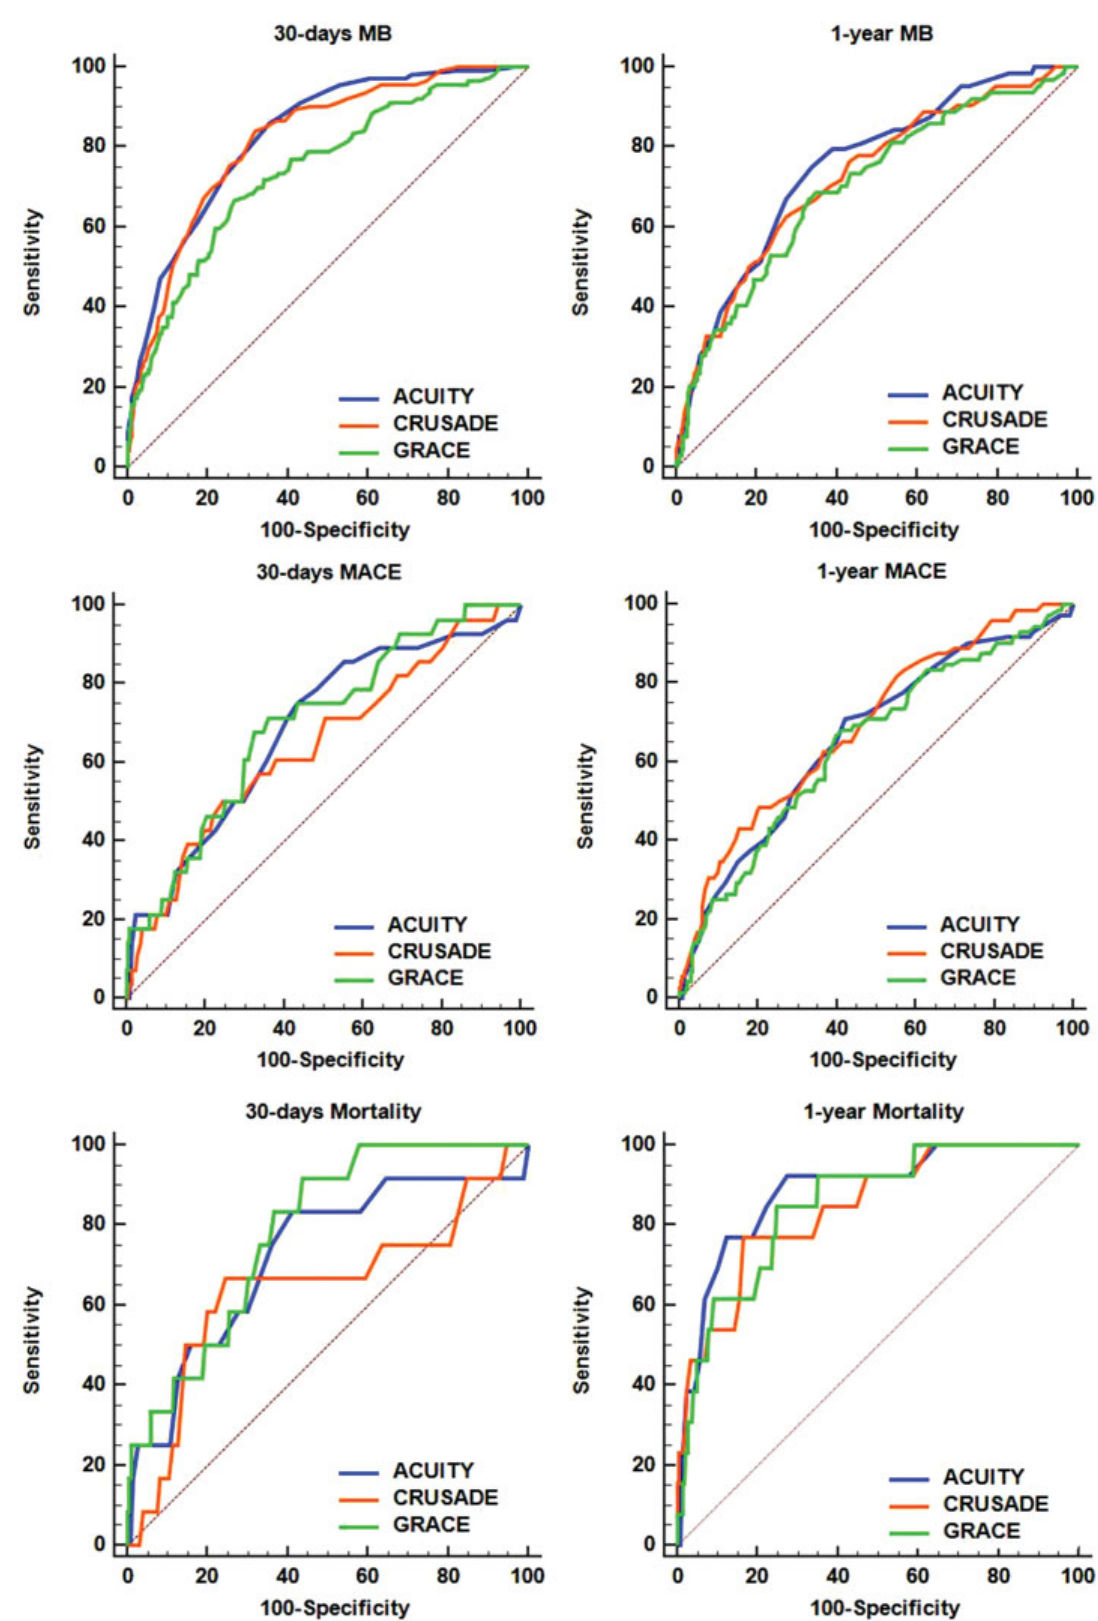
Fig. 3 Receiver operating characteristic curves for predicting major bleeding and death at 30 days and 1 year.